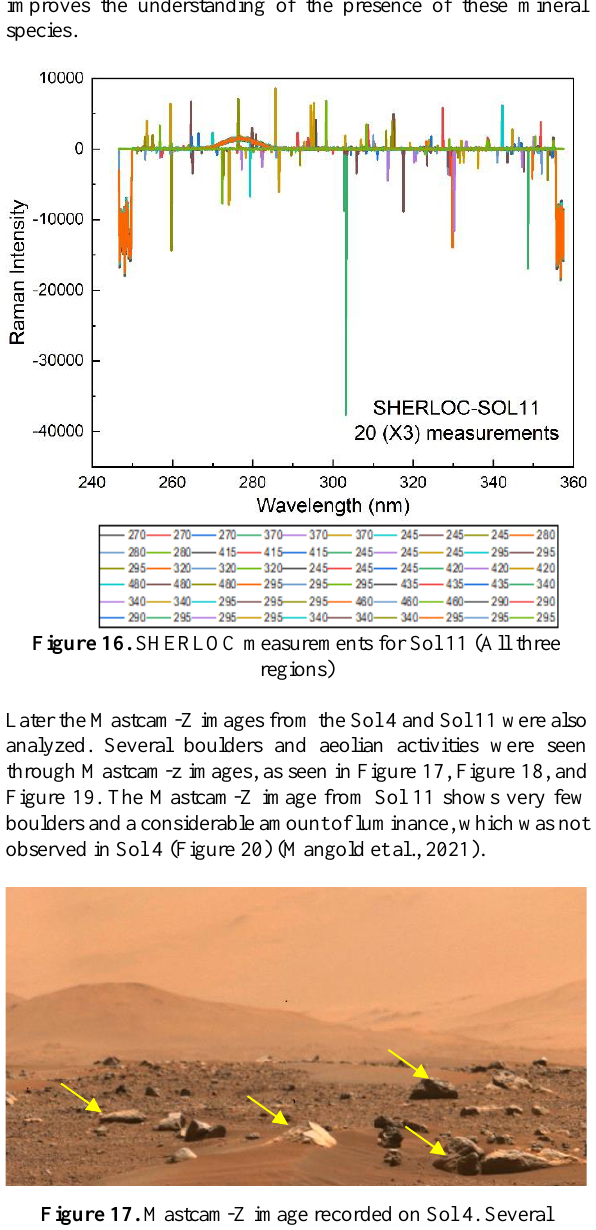
Figure 17. Mastcam-Z image recorded on Sol 4. Several boulders and rocks can be seen.